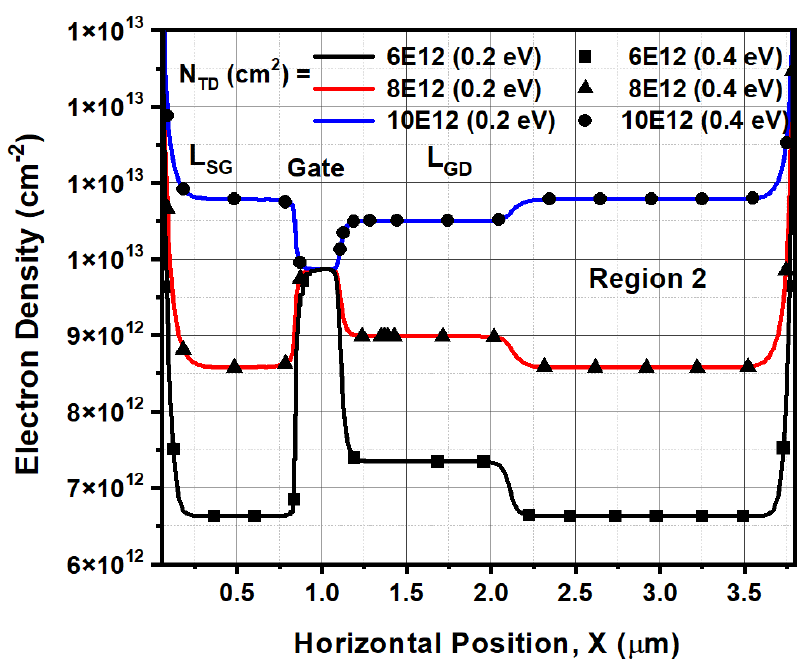
Figure 8. The 2DEG density versus lateral device distance (X) simulated for different E TD and N TD values under thermal equilibrium (zero-bias) conditions for Region 2.